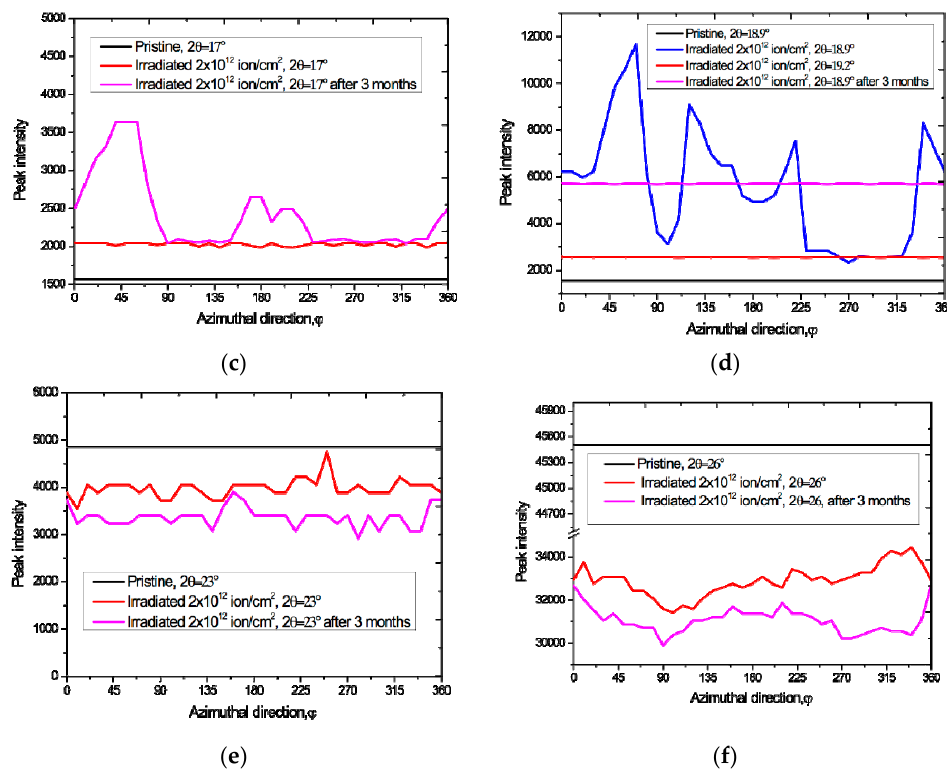
Figure 2 . Azimuthal variations in the intensity of diffraction reflections after irradiation with a dose of 2 × 10 12 ions/cm 2 (red lines), and after aging for 3 months (pink lines). Pristine behavior (black lines) is included for reference: ( a ) 2 θ = 9–10°; ( b ) 2 θ = 13°; ( c ) 2 θ = 17°; ( d ) 2 θ = 19°; ( e ) 2 θ = 23°; ( f ) 2 θ = 26°.